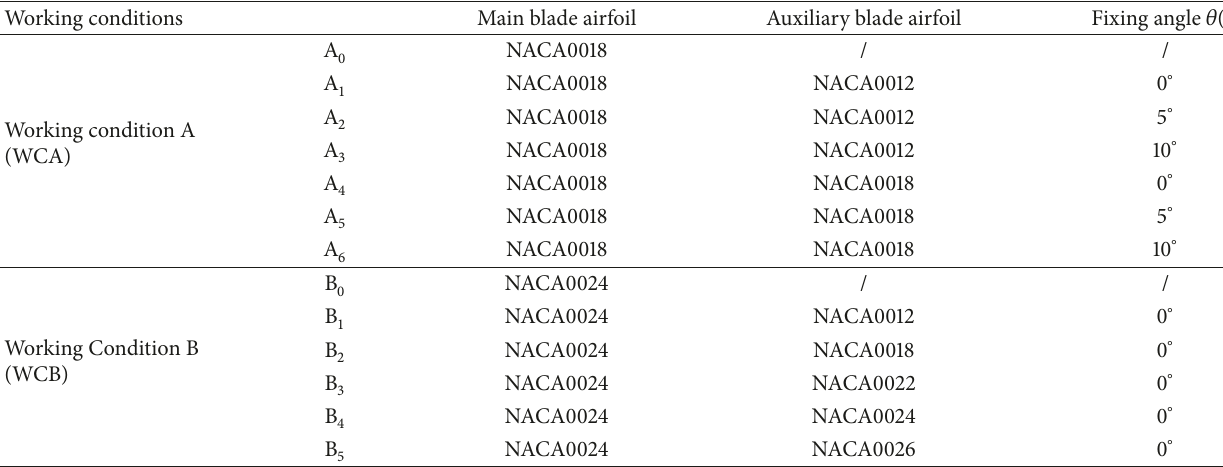
Table 2: Working conditions for